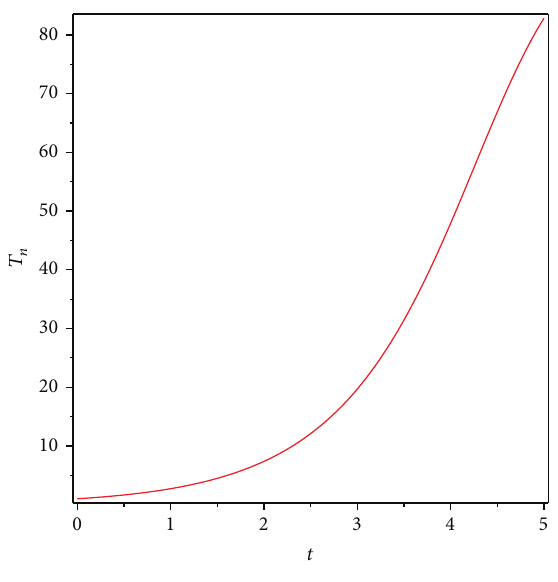
Figure 2: Analytical solution of (18) via